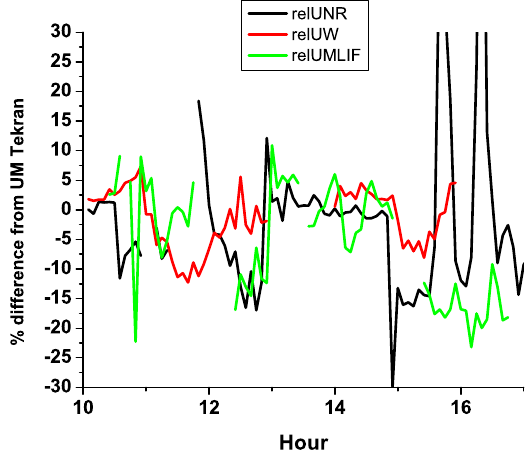
Figure 4. A 22h sampling period from 1 and 2 September. Com- parison of the UM (red line) and UNR (green line) Tekrans with the UM 2P-LIF (black line) concentrations. The concentrations for each instrument are scaled to force agreement during the second manifold spike at hour 33. These are the data from Fig. S3 with the concentration scale expanded to show only ambient